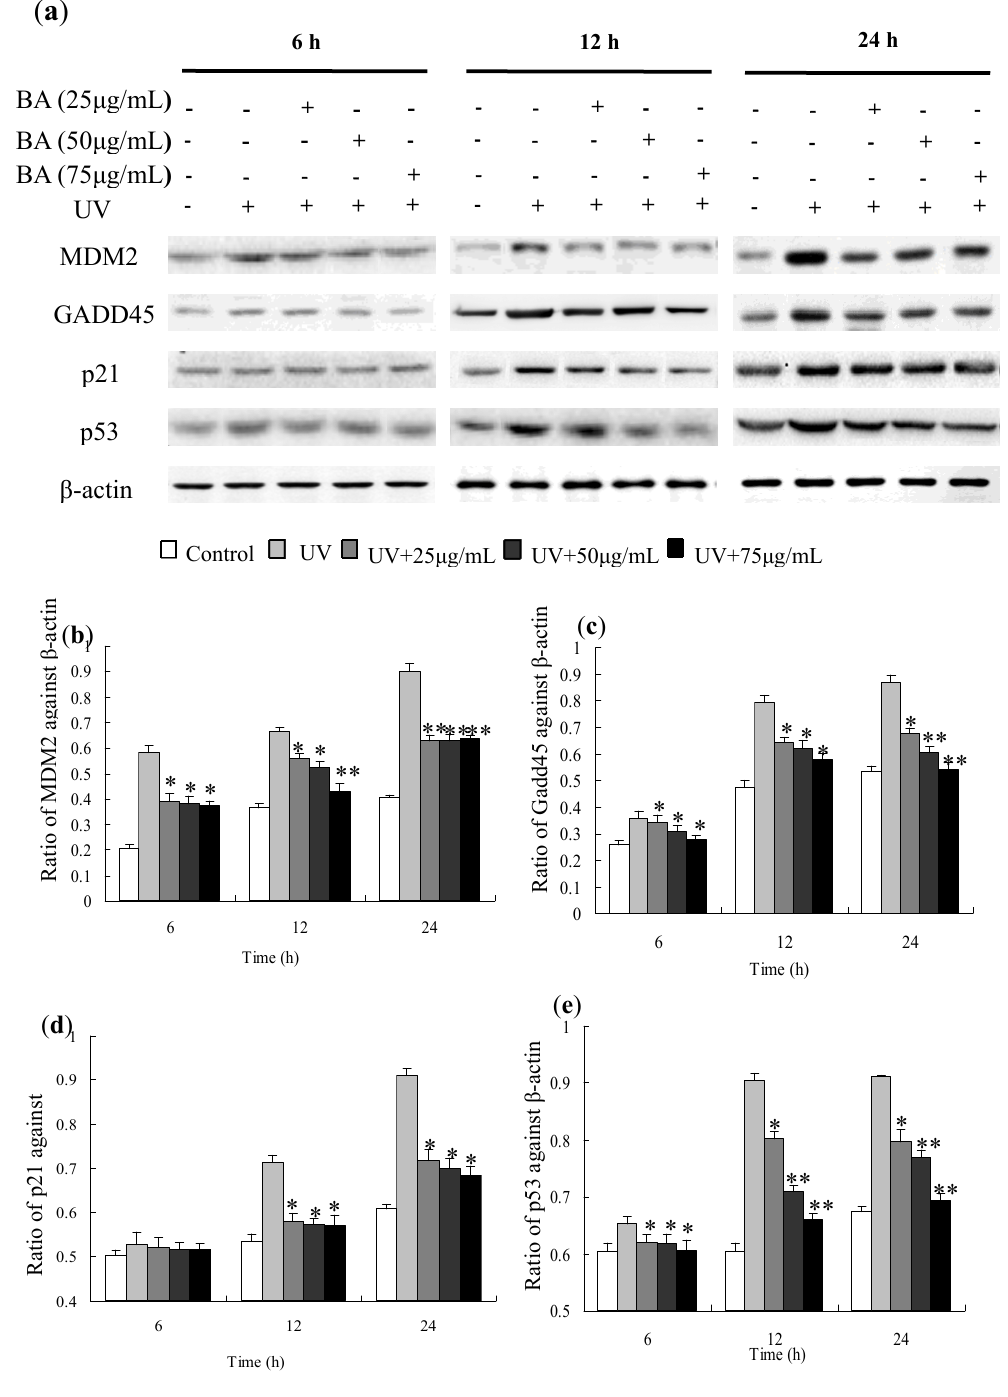
Figure 8. Western blot detection of Gadd45, MDM2, p53 and p21 protein expression in UV-irradiated and BA pre-treated HepG2 cells. ( a ) Western blotting with HepG2 cells that were treated with or without BA , irradiated or non irradiated with a UV dose of 30 mJ/cm 2 and harvested at the indicated times following treatment; ( b ) The relative expression of Gadd45 value after normalizing to β -actin; ( c ) The relative expression of MDM2 value after normalizing to β -actin; ( d ) The relative expression of p21 value after normalizing to β -actin; ( e ) The relative expression of p53 value after normalizing to β -actin. * p < 0.05, ** p < 0.01, compared with the UV